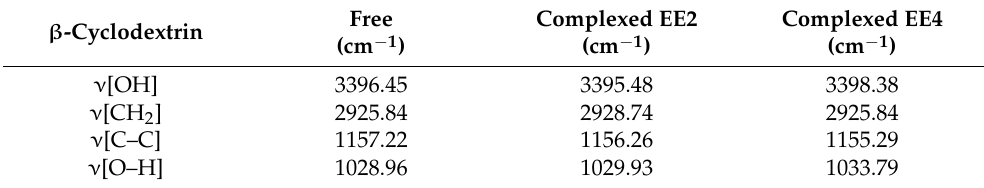
Table 2. Modified characteristic vibrations of β -cyclodextrin after